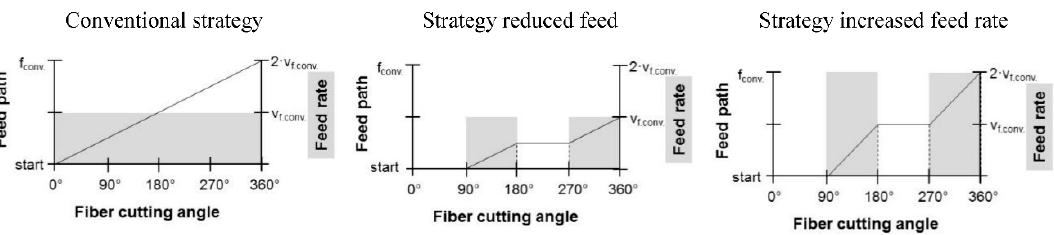
Figure 4. Strategies for drilling in unidirectional carbon fiber-reinforced plastics (UD-CFRP) with adapted feeds and feed rates.